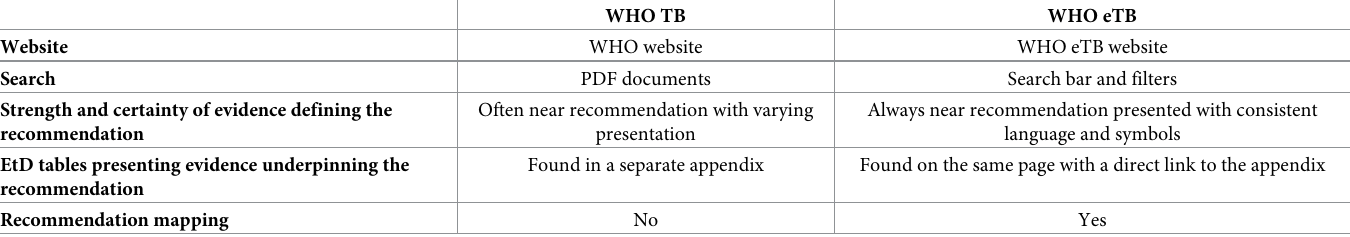
Table 1. Description of differences between WHO TB and WHO